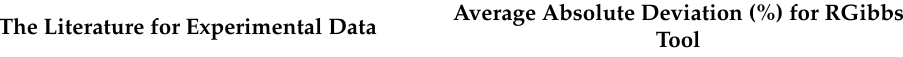
Table 1. Accuracy of RGibbs block in the ASPEN Plus simulator for the calculation of CO 2 frost point temperature